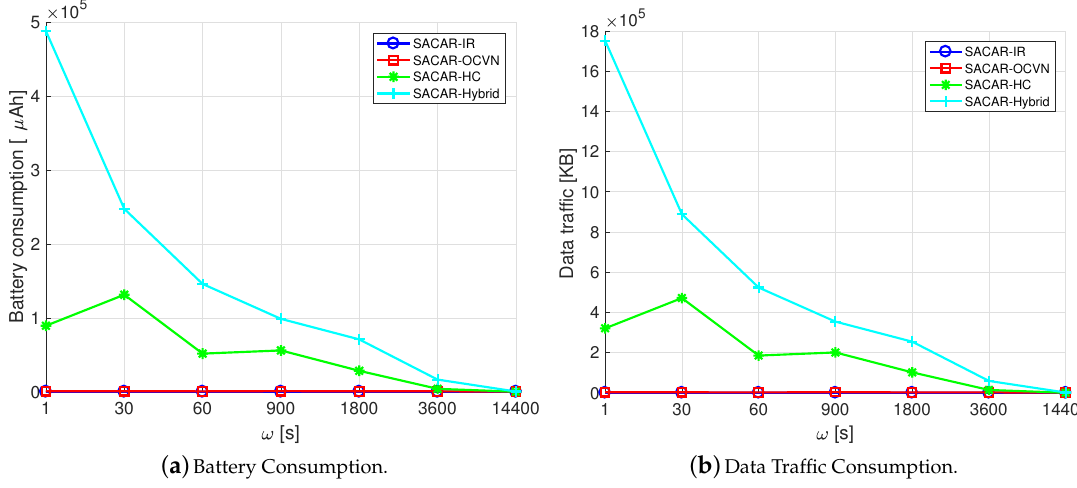
Figure 4. Resource consumption of SACAR